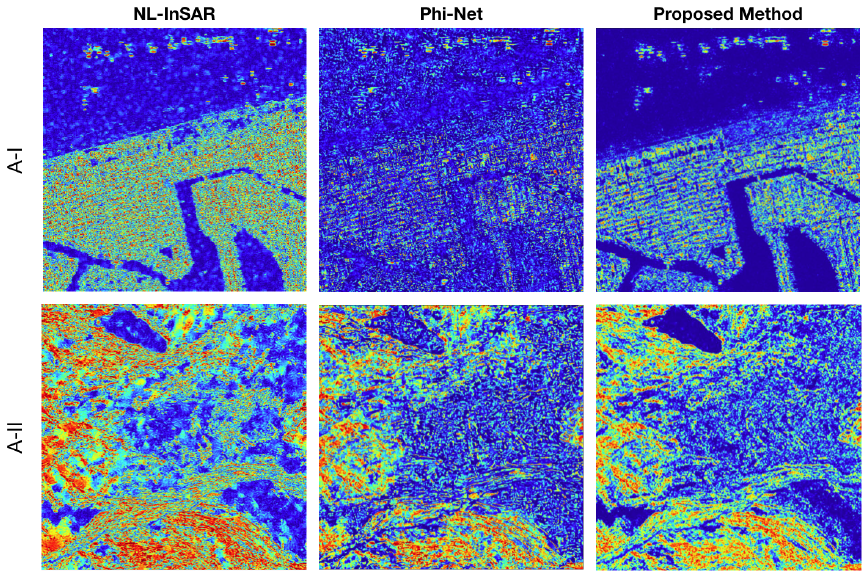
Figure 19. Coherence images of the considered sites A-I and A-II estimated using all the compared methods.